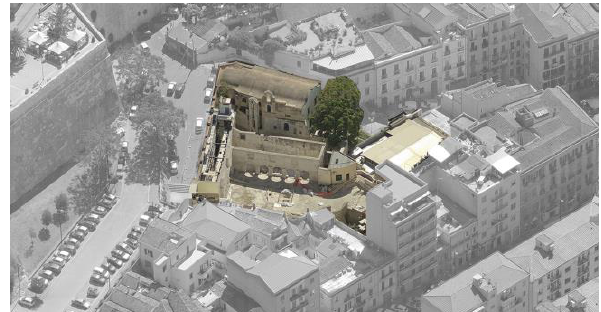
Figure 2. Aerial view on 45° of the ruins (Pilia